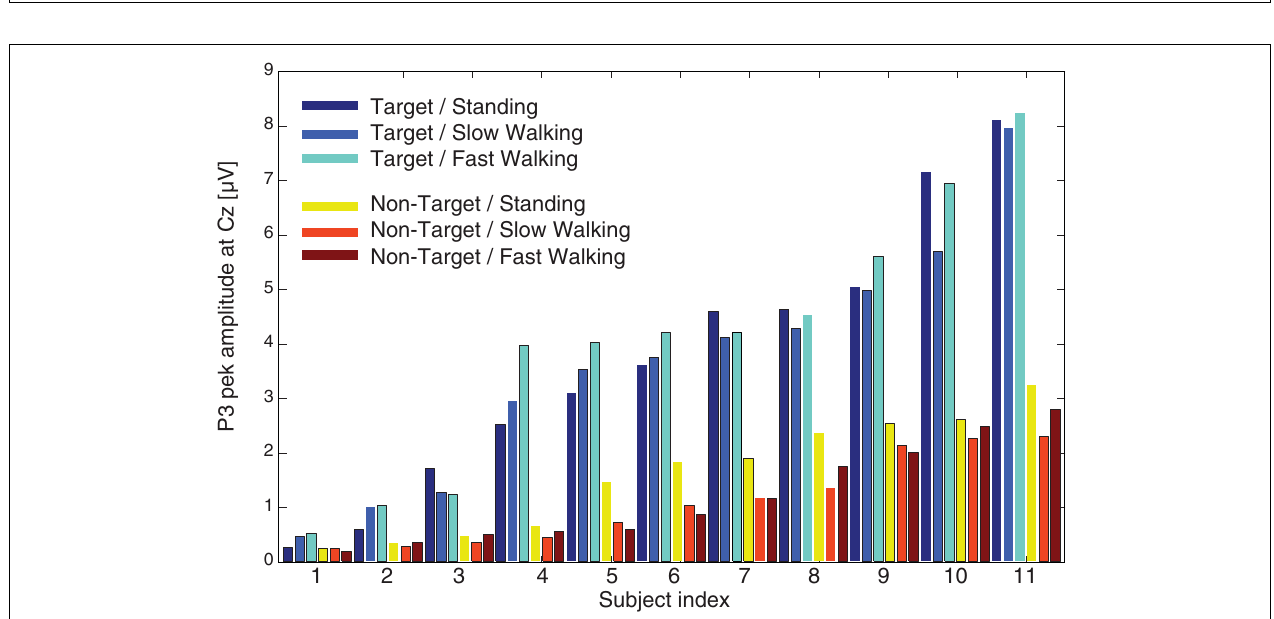
FIGURE 6 | Individual P3 peak amplitudes at electrode Cz for target stimuli (cool colors) and non-target stimuli (warm colors) in the three movement